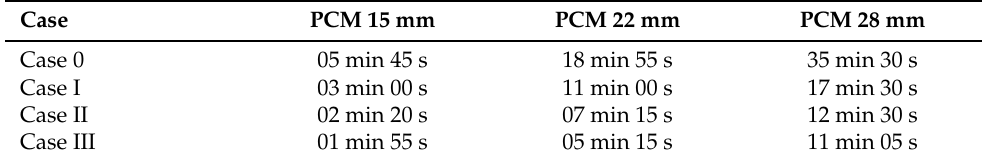
Table 6. Water melting time.